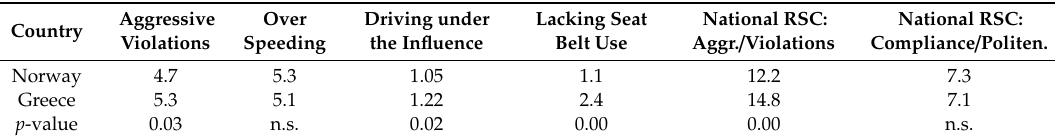
Table 14. Mean scores for men from Oslo (N = 94) and Athens (N = 74), between 27 and 55 years, with high school or 3–4 years of university education on the four behavior variables in the study and the two variables for national road safety culture. p -values are indicated (n.s. = not